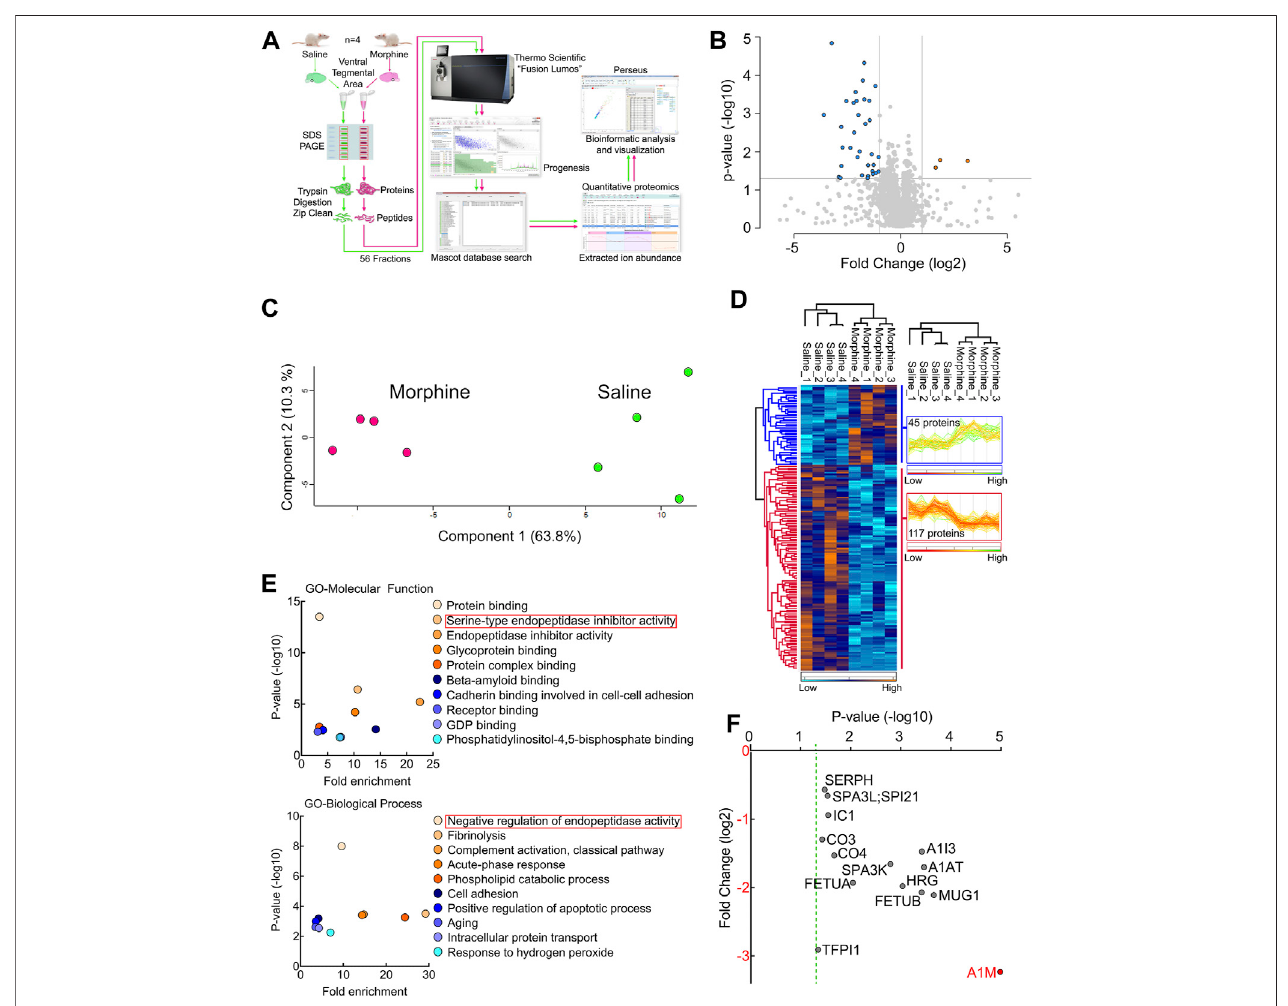
FIGURE1| Proteomicanalysisoftheendogenouscannabinoidsystem-relatedproteinsinratVTA. (A) ExperimentaldesignforVTAtissuecollection. (B) Schematic diagramofthelabel-freequantitativeproteomicsexperimentalapproach.VTAtissuesacquiredfromrepeatedmorphine-orsaline-treatedratswereprocessedandused for performingproteomicanalysisasdescribed inMethodsand Materials. (C) Avolcanoplotoftheproteins identi fi edintheVTA tissues treatedwithsustainedmorphine or saline. Above thehorizontal gray linerepresents thecut-offfora p valueof < 0.05 while thetwovertical lines represent thecut-off valuesof2-fold changeineither the positive or negative direction. (D) Unbiased principal component analysis (PCA) of the 162 signi fi cantly affected proteins from the 2-way ANOVA analysis of the quantitative proteomics data revealed that the protein expression differences of the individual biological samples within each group were consistent. (E) Unbiased hierarchical clustering of the 162 signi fi cantly affected proteins in the sustained morphine vs. saline treatment groups con fi rmed that the expression patterns across the different individual biological samples cluster together. (F) Scatter plots of the Gene Ontology (GO) enrichment fi ndings for the signi fi cantly affected proteins after repeated morphine treatment. (G) Scatter plot of the endopeptidase inhibitors that are signi fi cantly affected by repeated morphine treatment. The Fold Change axis is labeledredtorepresentthattreatmentwithmorphineresultsinadecreaseintheendopeptidaseinhibitorproteinsidenti fi ed.Theverticaldashedgreenlinerepresentsthe p cut-off value of < 0.05. α -1-macroglobulin is labeled in red to highlight the most signi fi cantly affected protein after morphine treatment. n (cid:1) 4 per group.